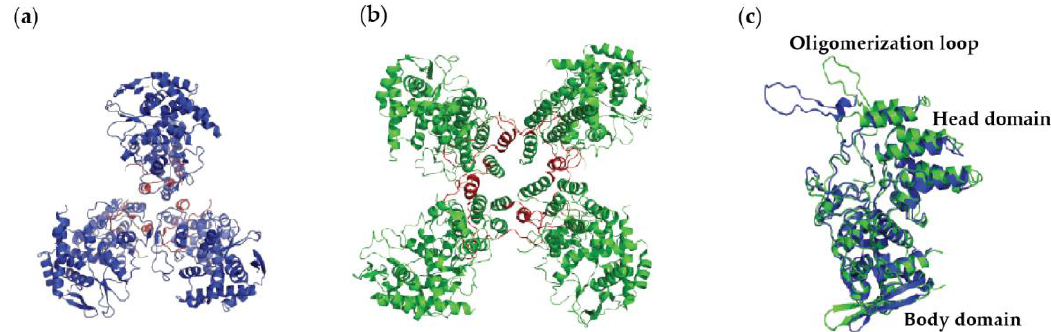
Figure 1. X-ray structures of influenza virus nucleoproteins. ( a ) Influenza A nucleoprotein (A/NP) (PDB ID: 2IQH) in blue forms a trimer, whereas ( b ) Influenza B nucleoprotein (B/NP) (PDB ID: 3TJ0) in green forms a tetramer. The oligomerization loops are coloured red on both ( a ) and ( b ). ( c ) Overlay of A/NP and B/NP. The overall folds of A/NP and B/NP are very similar with a head and a body domain. The root-mean-square deviation (r.m.s.d.) is 1.49 Å for 458 Cα. The exchange domains of the